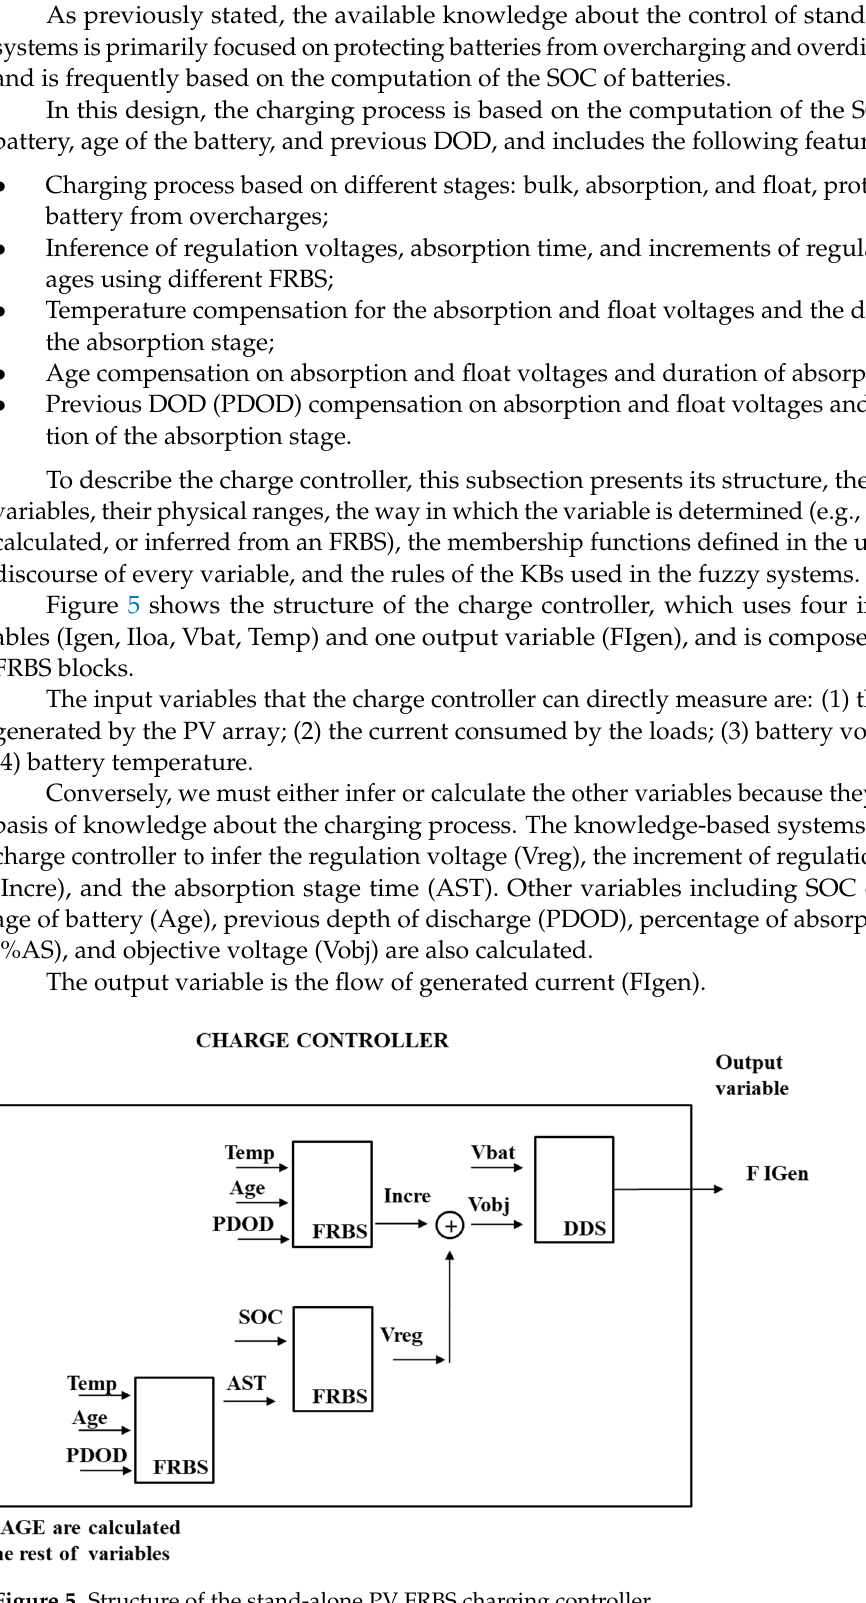
Figure 5. Structure of the stand ‐ alone PV FRBS charging controller.